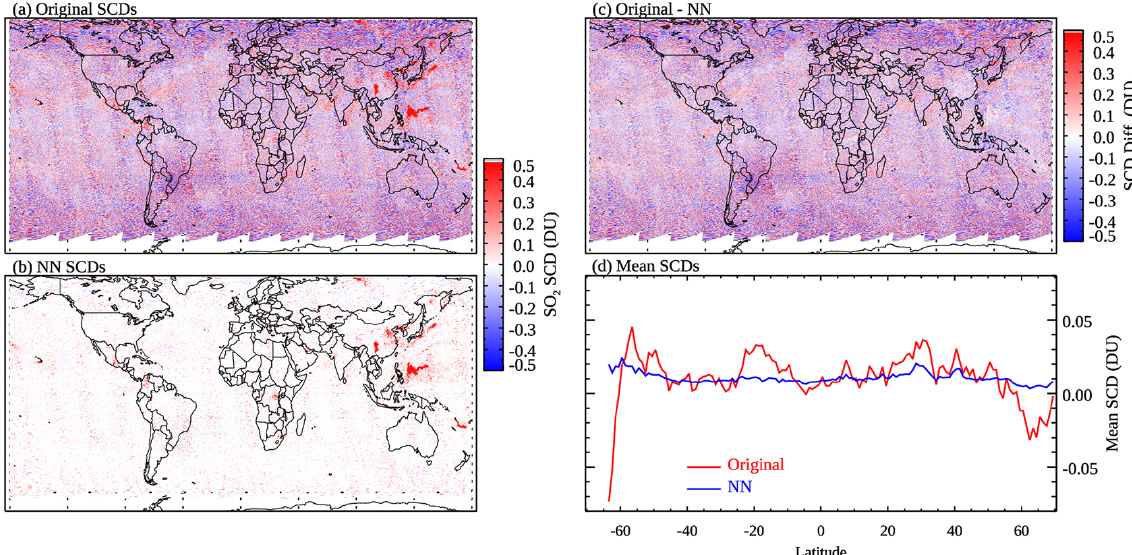
Figure 4. The (a) original, (b) NN-analyzed OMI SO 2 SCDs and (c) their differences for 16 April 2005. (d) Mean SO 2 SCDs for 1 ◦ latitude bands over generally clean areas (monthly mean SRR < 3), calculated from (red) the original and (blue) NN-analyzed SCDs for the same day.